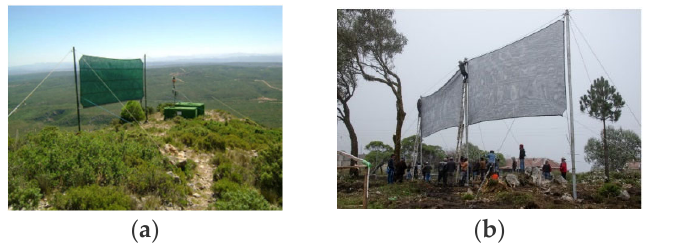
Figure 3. Different types of fog harvesting systems. ( a ) LFC fog collector situated at Mount Machos (Spain) [34]. ( b ) LFC fog collector situated at Guatemala [44].